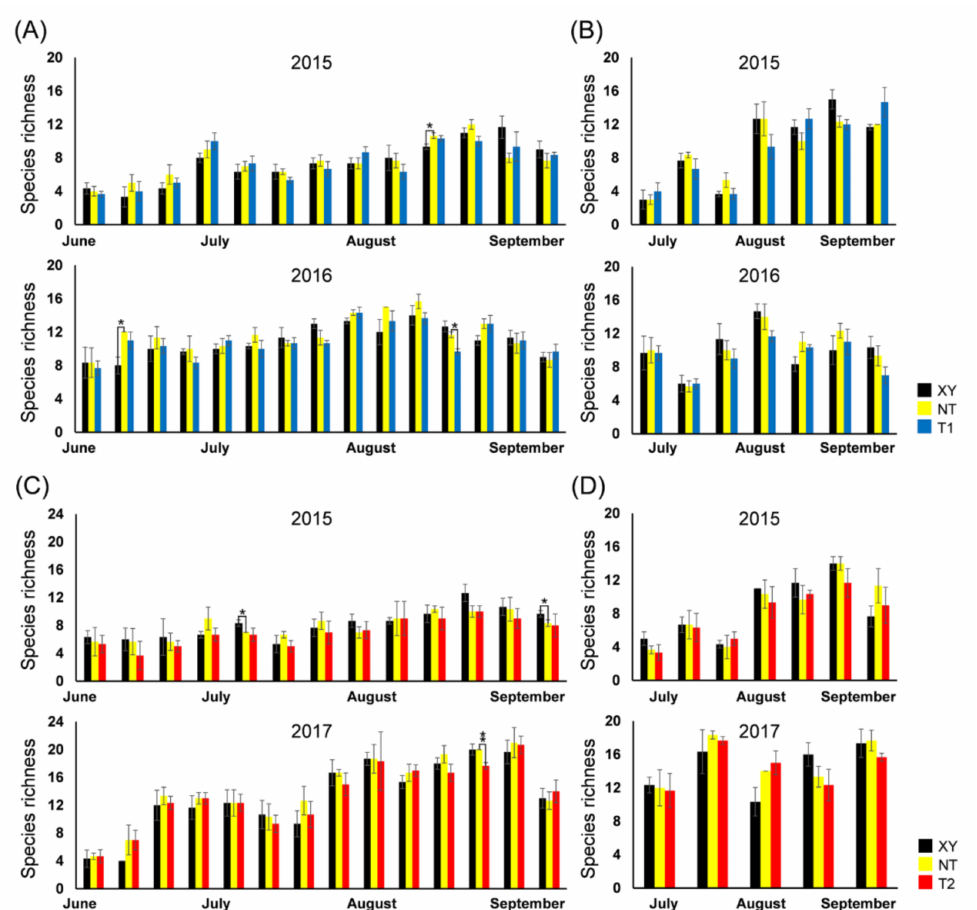
Figure 3. From 2015 to 2017, the species richness ( S ) dynamics of the arthropod community in the plots of cultivated variety XianYu335 (XY), non-transgenic recipient variety DBN318 (NT), transgenic maize DBN9868 (T1) and DBN9936 (T2). ( A ) The S of plant-inhabiting arthropods in XY, NT and T1; ( B ) the S of ground-dwelling arthropods in XY, NT and T1; ( C ) the S of plant-inhabiting arthropods in XY, NT and T2; ( D ) the S of ground-dwelling arthropods in XY, NT and T2. Y-axis: Mean ± SE ( n = 3) of S at each sampling point. We only compared XY with NT and NT with T1 or T2 by using a Student’s t -test. Asterisks denote significant differences, where p < 0.05 (*), p < 0.01